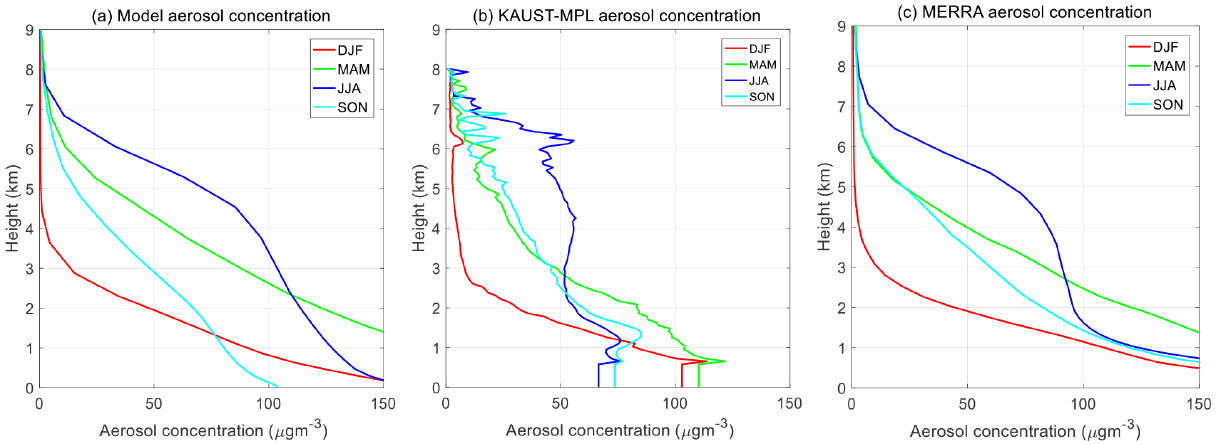
Figure 13. Comparison of the vertical profiles of total aerosol concentrations among (a) the model, (b) KAUST–MPL, and (c) MERRA-2 data for different seasons at KAUST. For MERRA-2 and model data, total aerosol concentration is the sum of dust, sea salt, sulfate, OC and